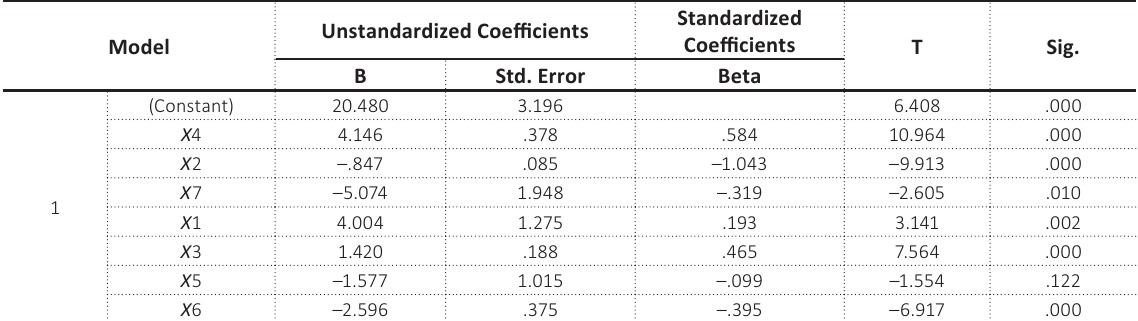
Table 6. Coefficients